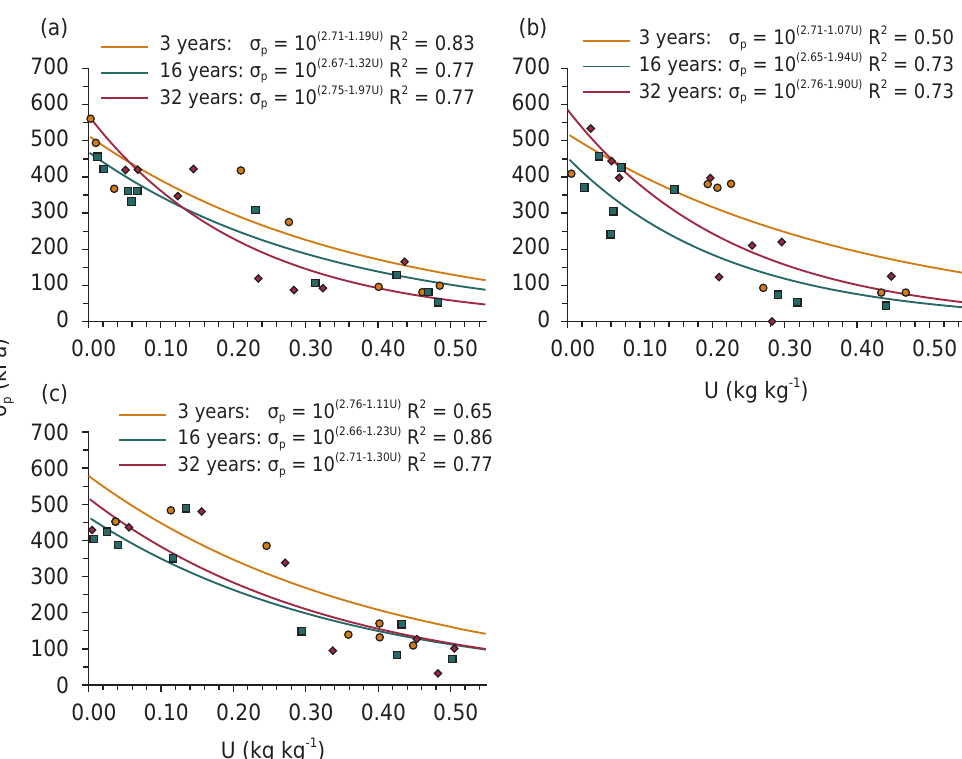
Figure 2. Soil load-bearing capacity models in function of the water content (U) of an Ultisol, in areas cultivated with coffee with different deployment times (3, 16, and 32-years areas), under mechanized management systems, in the planting row, at different soil layers: 0.00-0.10 m (a), 0.10-0.20 m (b), and 0.20-0.40 m (c).